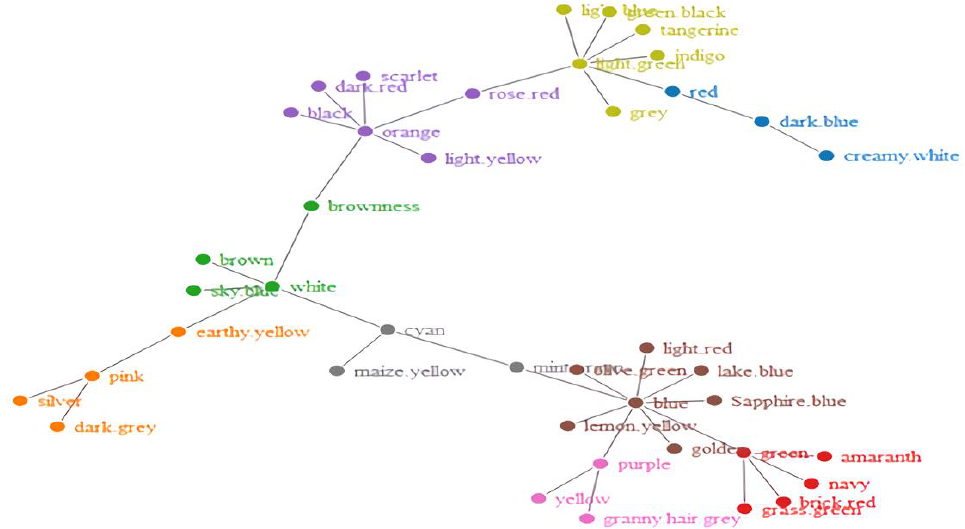
Figure 5. Network visualization of the Mandarin-color lexical network.